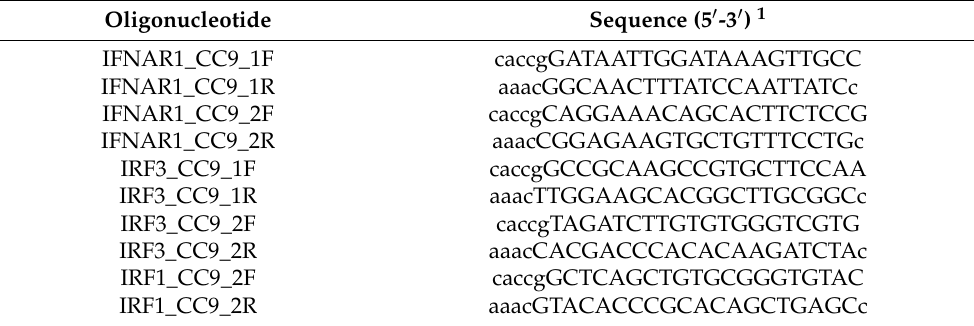
Table 2. Oligonucleotides for annealing and cloning into Bbs I of plasmid pSpCas9(BB)-2A-GFP (PX458). Oligonucleotide